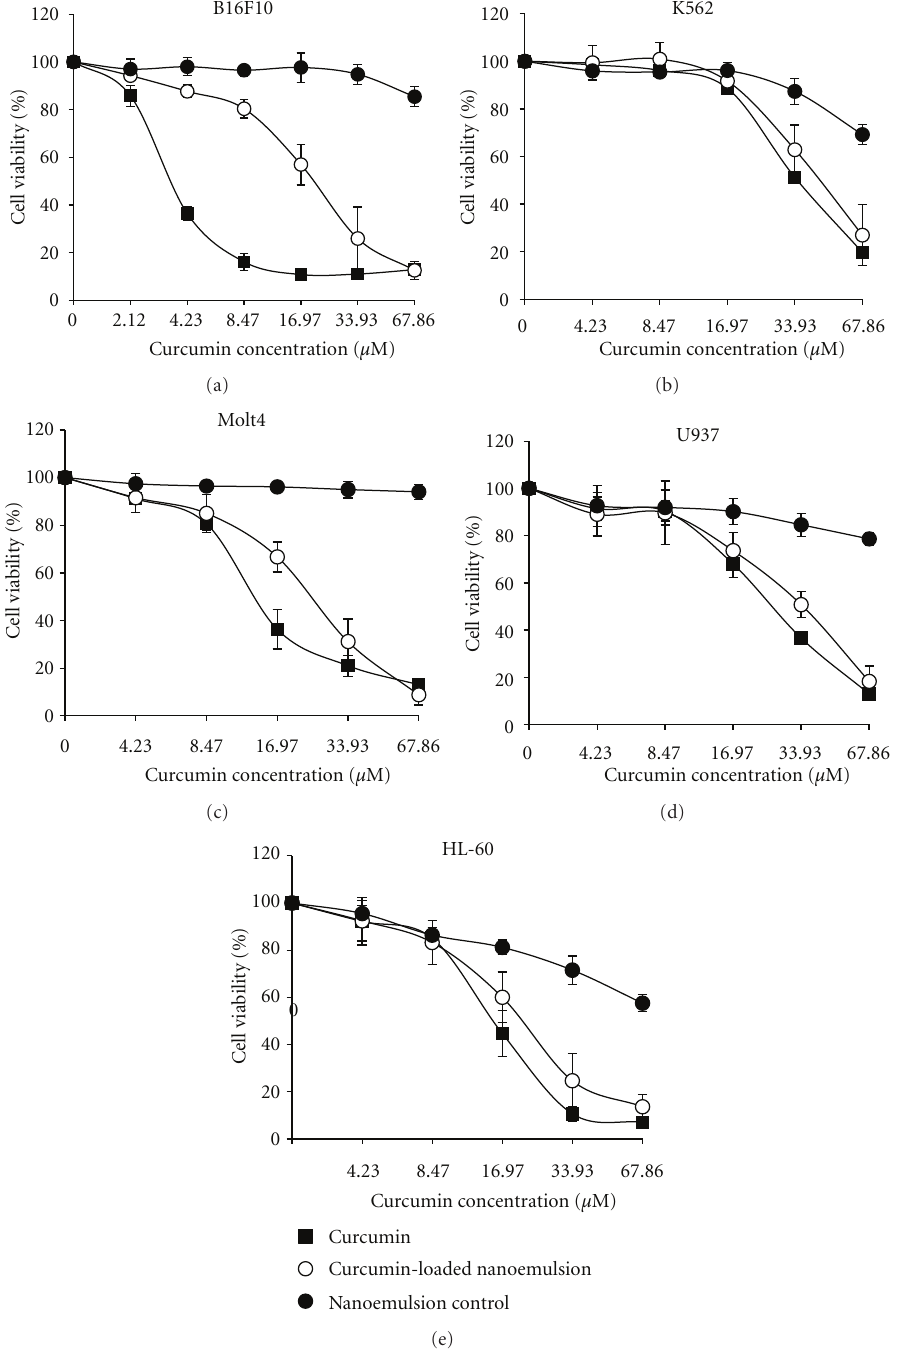
Figure 8: Cytotoxicity of curcumin and curcumin-loaded nanoemulsionon B16F10, K562, Molt4, U937, and HL-60 cell lines. (cid:2) : curcumin treatment, (cid:2) : curcumin-loaded nanoemulsion, (cid:3) : nanoemulsion control. Data are the mean ± standard error (SE) of three independent experiments ( n =